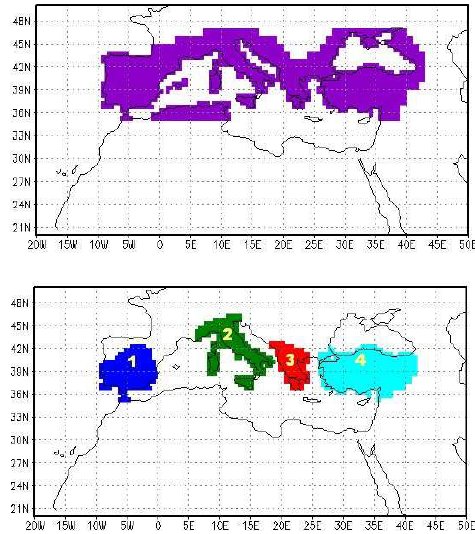
Fig. 4. Representation of the Mediterranean basin and smaller areas considered in this study (for the scPDSI data